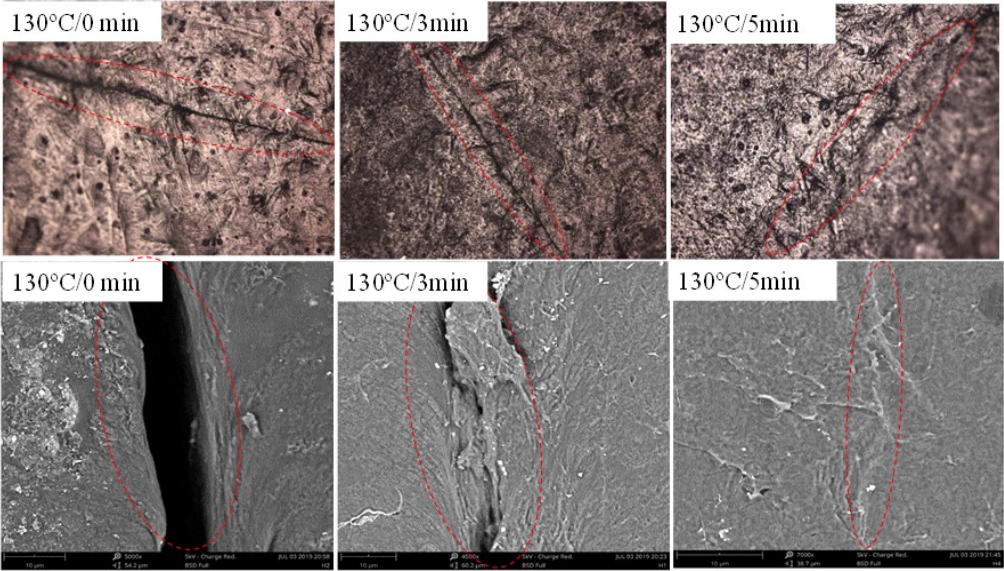
Figure 13. Optical and SEM images of scratch sample healed at 130 °C for different time using IR light.